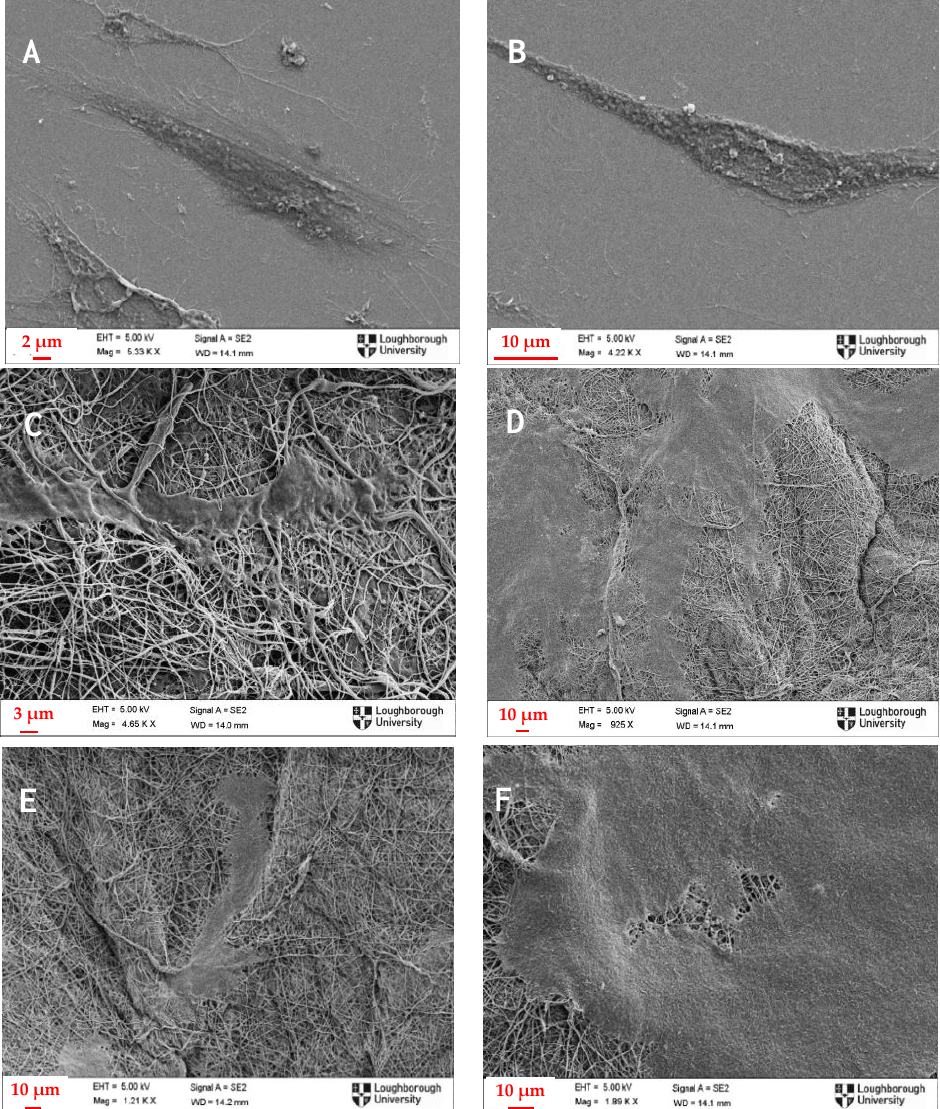
Figure 8. Scanning Electron Microscope Images of: ( A , B ) fibroblasts on glass slide; ( C ) 1:3 PANI/CS membrane; ( D ) 3:5 PANI/CS membrane; and ( E , F ) 1:1 PANI/CS membrane.